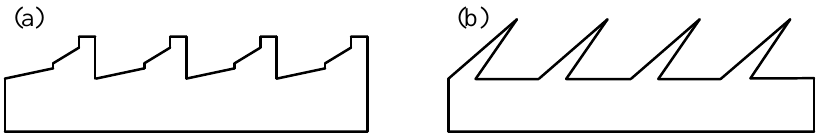
Figure 3. Non-triangular groove grating structure. ( a ) Convex grating with structured-groove profile [34]. ( b ) Various groove shape profiles used for echelles [35].